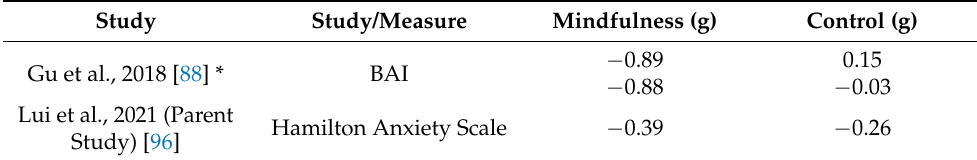
Table 6. The effect sizes from measures of anxiety used in single